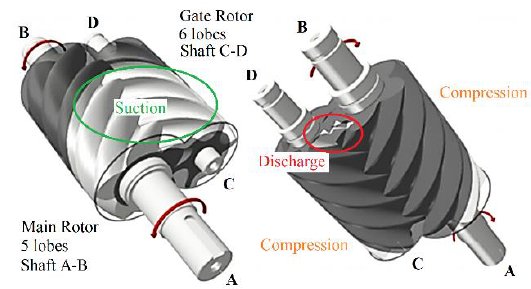
Figure 1. Conventional twin screw rotors with a 5–6 profile.